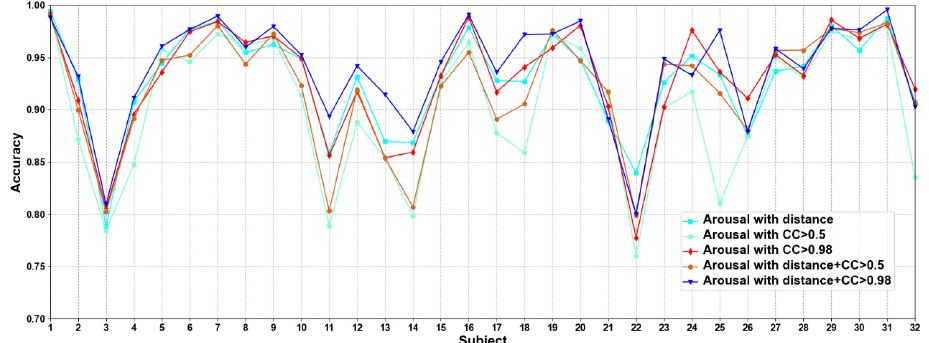
Figure 6. Classification accuracies on each subject on arousal under construction of different adja- cency